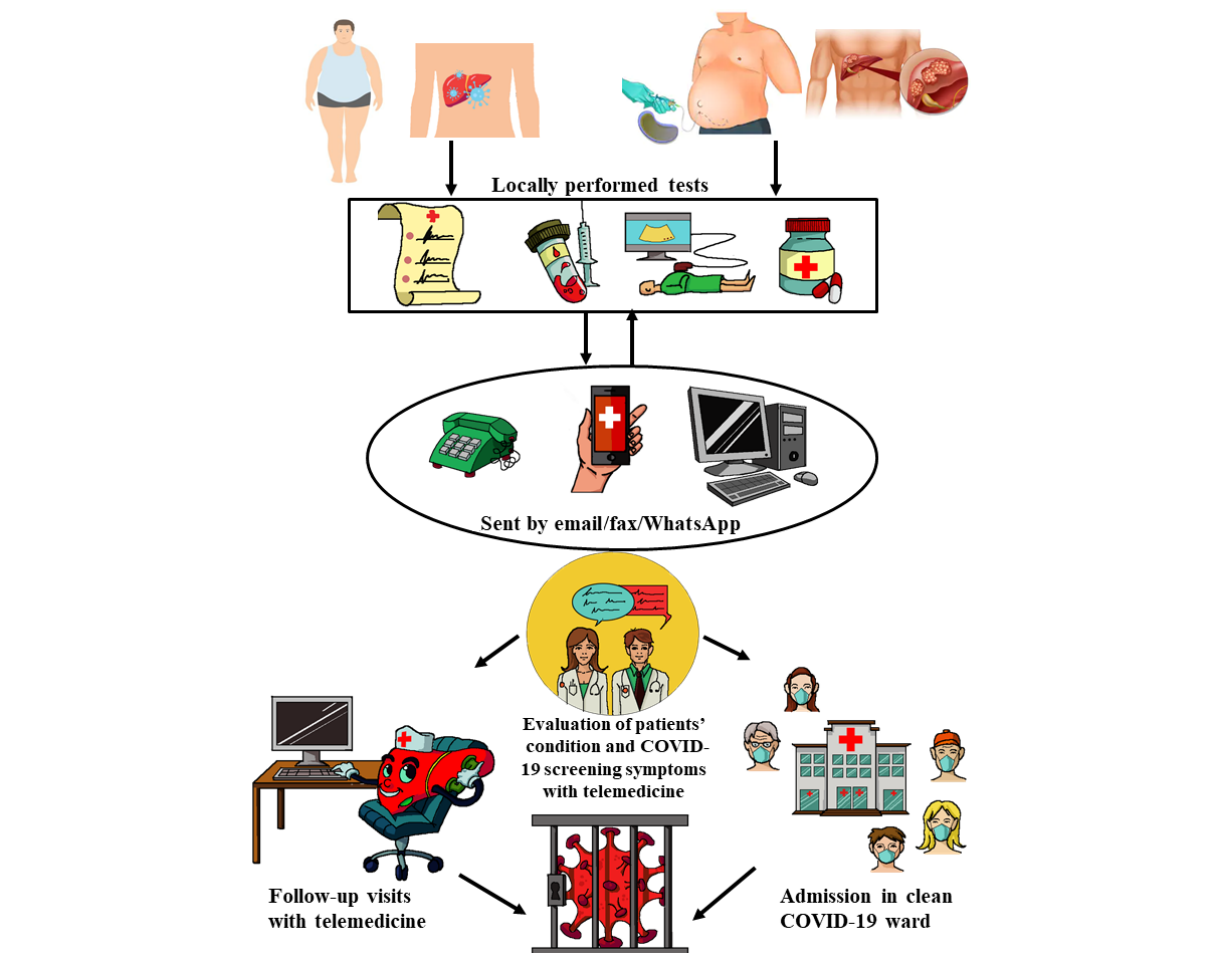
Figure 1. Graphical representation of telemedicine activity during the COVID-19